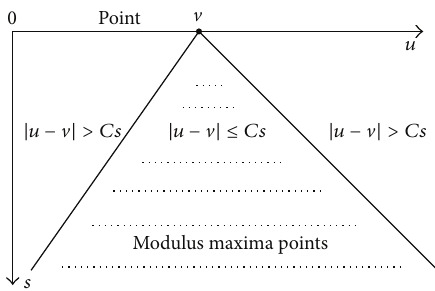
Figure 2: The conical surface composed of modulus maxima